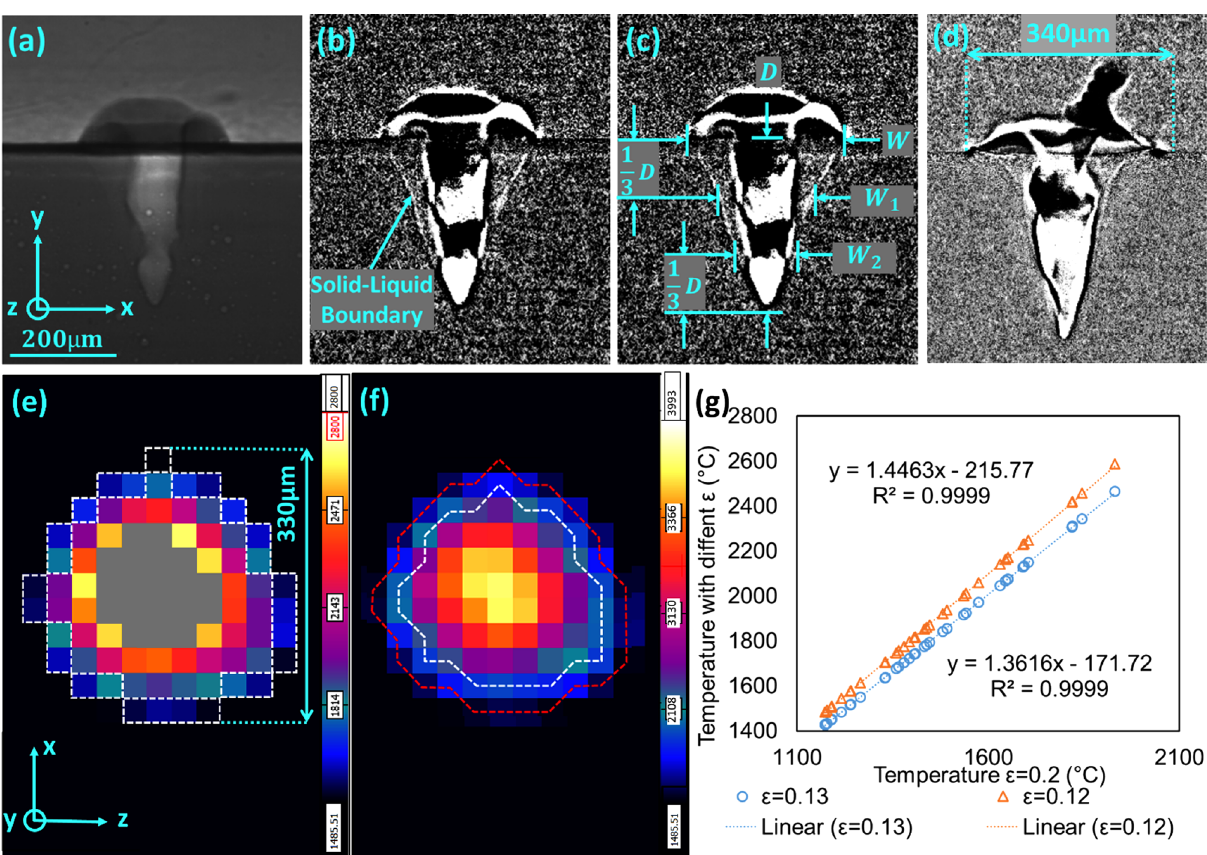
Figure 2. The ( a ) un-processed and ( b ) processed high-speed X-ray imaging of a 410 SS melt pool. The backgrounds have all been removed in the processed one, and the boundary of the melt pool becomes clear. ( c